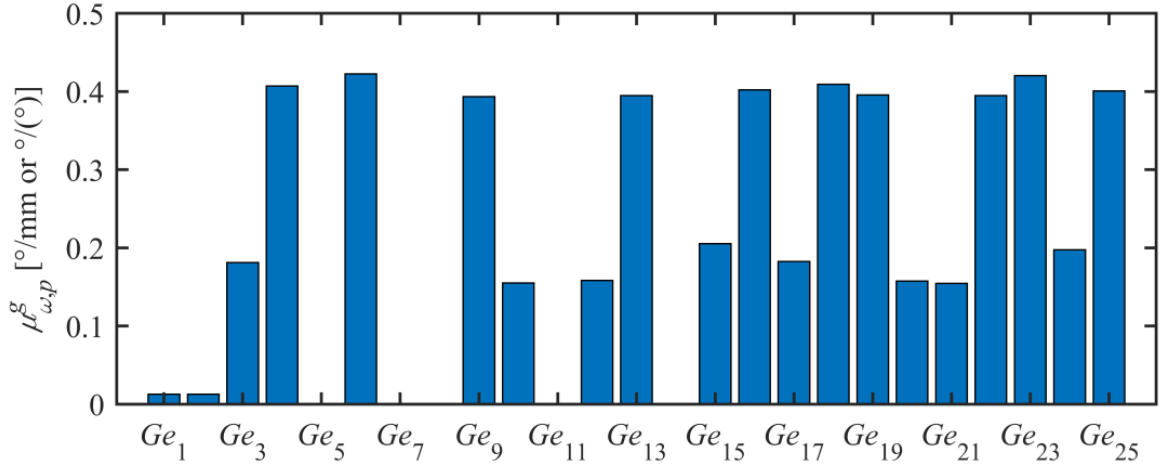
Figure 8. Global sensitivity of the average angular comprehensive deformation with respect to Ge p s.